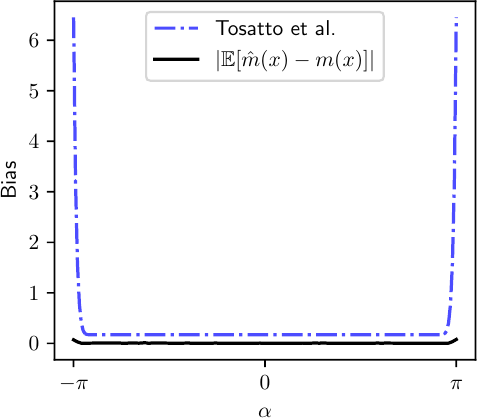
Figure 2. We propose a study on how the bias varies w.r.t. the dimension. While the bias grows almost linearly in the high density region (i.e., x = 0), it tends to grow exponentially in lower densities (i.e., x = 0.75). In both cases, our bound perform correctly.